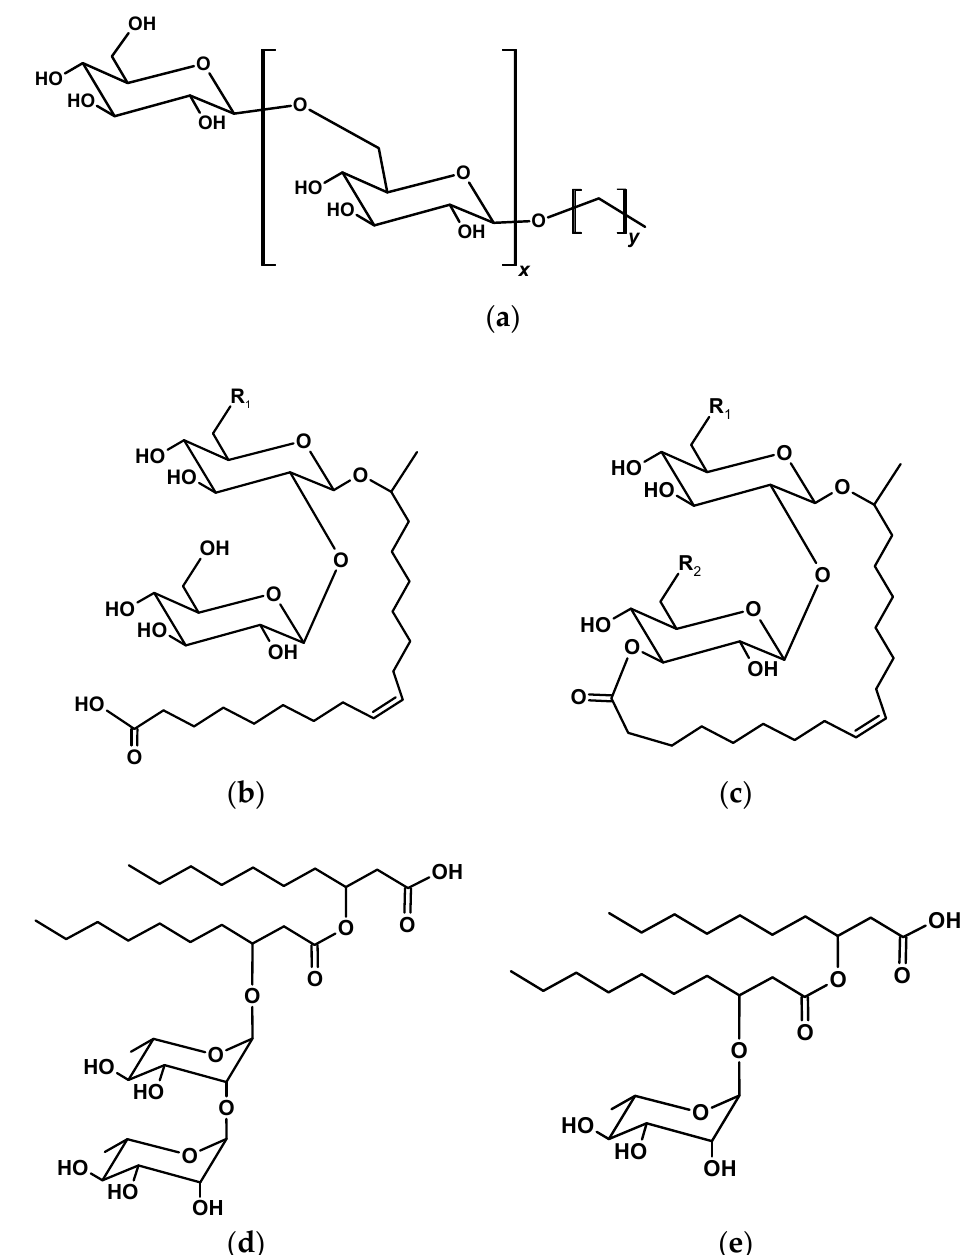
Figure 1. The general structures of surfactants used in this study. ( a ) Alkyl polyglycoside; ( b ) sophorolipid open structure; ( c ) sophorolipid lactonic structure; R 1 and R 2 groups can be a hydroxyl or acetate group (OH or OAc); ( d ) di-rhamnolipid; ( e ) mono-rhamnolipid.